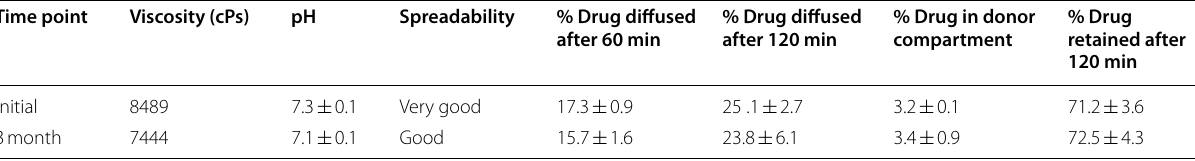
Table 8 Stability results of OZ (gamma oryzanol) niosomal gel Time